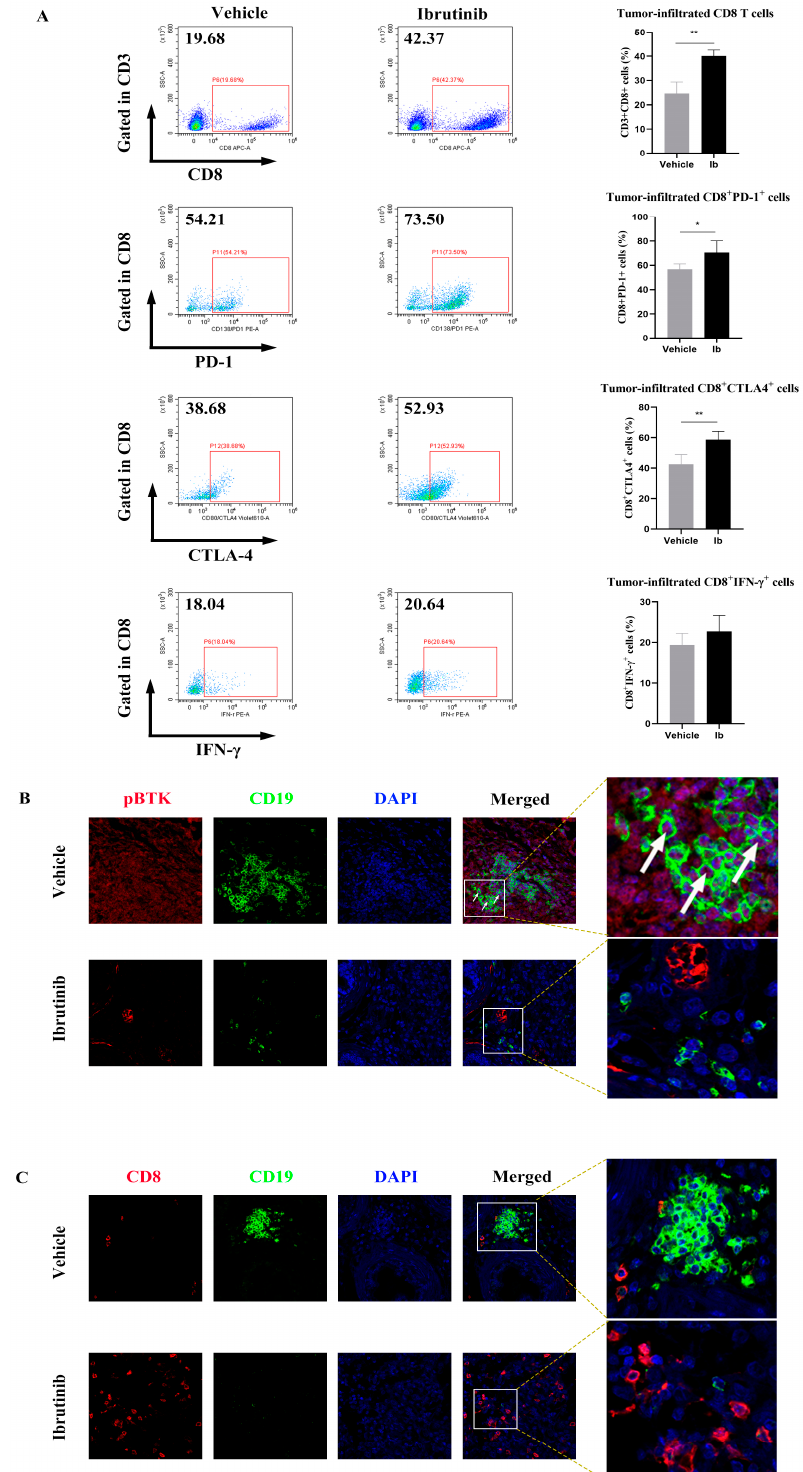
Figure 4. In vivo ibrutinib monotherapy leads to an increase in high-IRs CD8 + T cell infiltration in PCa. ( A ) Flow cytometry analysis of tumor − infiltrated CD8 + T cells in PCa. The plots show that CD8 + T cells were increased with high expression of PD-1 and CTLA4 but IFN- γ production was unchanged by ibrutinib monotherapy ( n = 4). ( B , C ) Representative mIHC images of mouse PCa tissues showing changes in CD19 + B cell (green) and CD8 + T cell (red) infiltration after treatment (original magnification: 400 × ). A p value less than 0.05 was considered statistically significant. IRs, inhibitory receptors. *, p < 0.05; **, p <